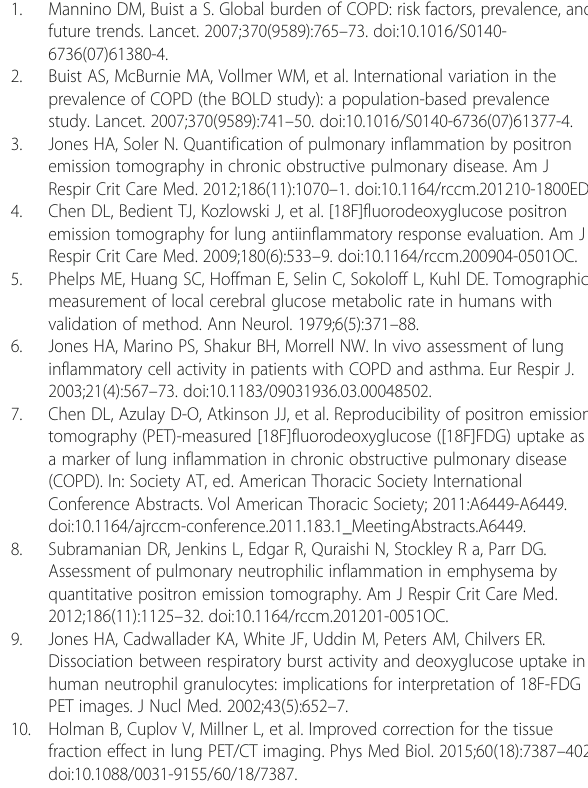
Additional file 1: Supplemental data for quantitative analysis of dynamic 18 F-FDG PET/CT for measurement of lung